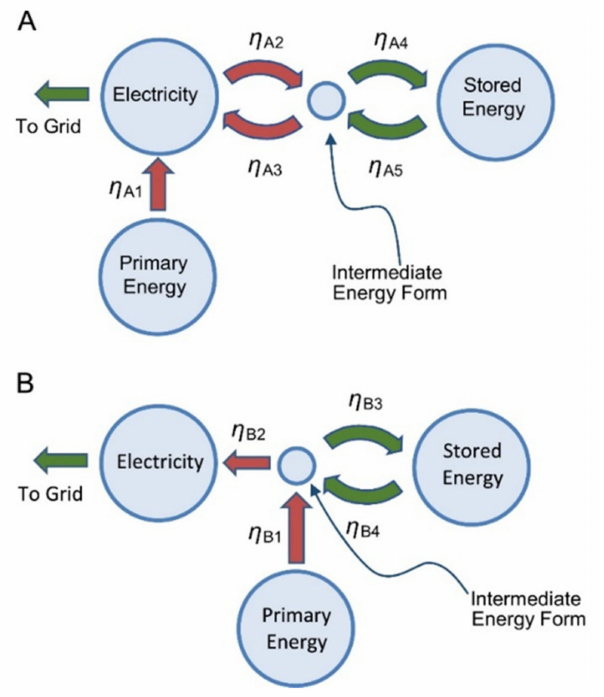
Figure 1. Comparison of energy conversions between ( A ) standalone and ( B ) generation-integrated energy storage configurations. From